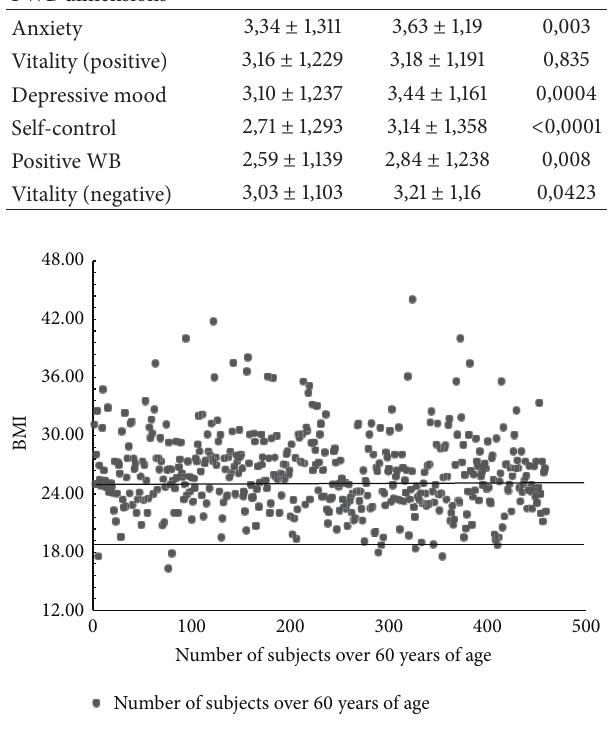
Figure 1: BMI values of all subjects over 60 years of age examined in the study.